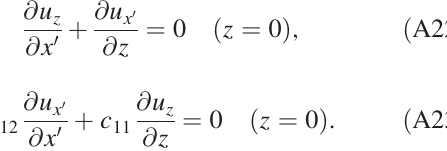
FIG. 5. Dispersion relation ω Rayleigh-type SAW modes for propagation along ˆ x 0 ∥ ½ 110 (cid:2) . If not stated otherwise, we refer to the lowest frequency solution as the SAW mode (solid line).